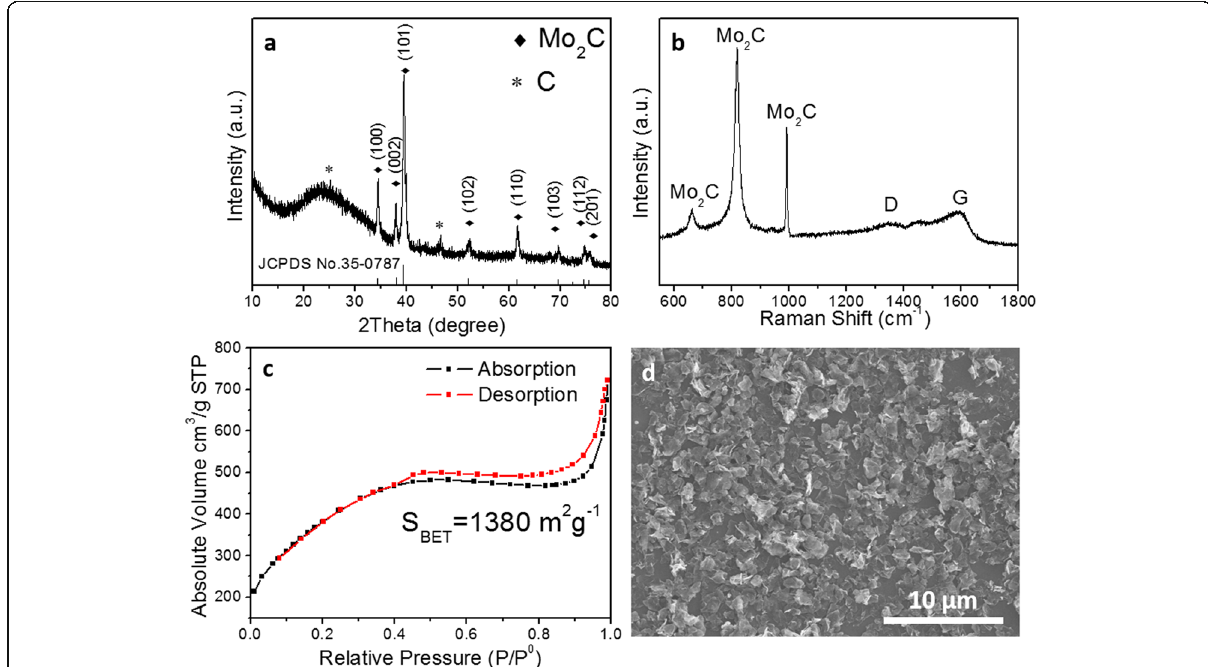
Fig. 2 The physical characterization of Mo 2 C/NPC. a XRD pattern, b Raman spectra, c N 2 adsorption-desorption isotherm, and d SEM